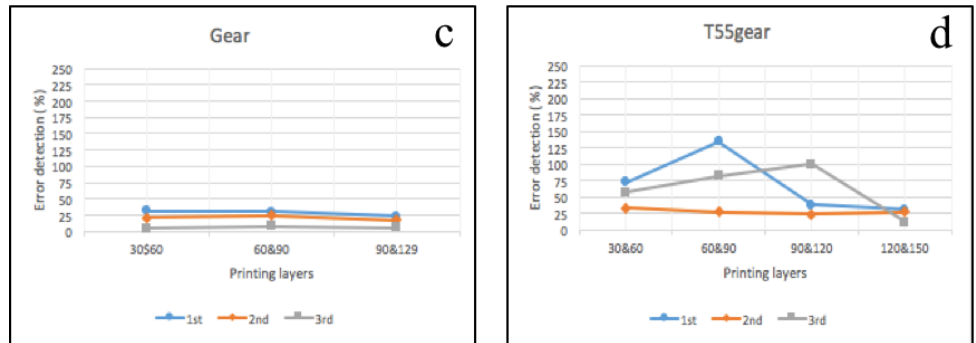
Figure 12. Image pre-processing—SIFT and RANSAC rescale and rectification: the error detection of failure state for ( a ) sun gear; ( b ) Prism; ( c ) gear; and ( d ) t55gear.